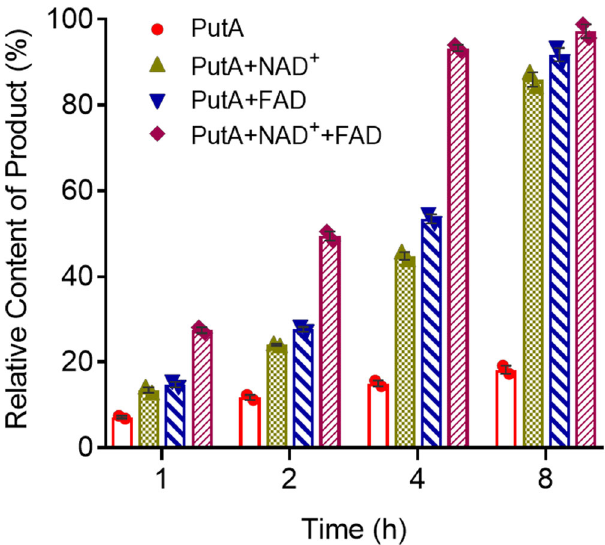
Fig. 4 Effects of NAD + and FAD on the enzymatic activity of PutA. The production of L-glutamate by PutA was analysed to evaluate the activity of PutA for converting L-proline with or without NAD + or FAD. The amounts of L-proline before the catalytic reactions were arbitrarily de fi ned as 100% and used to normalize the reduction in the amount of L-proline. The data are the means ± standard deviations of two independent